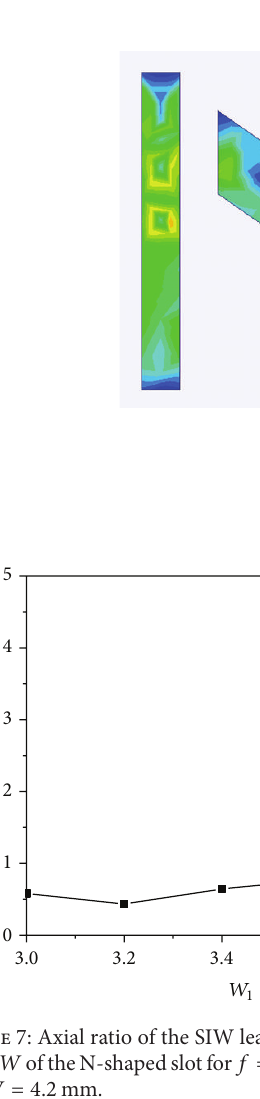
Figure 9: Measured and simulated 𝑆 -parameters of the antenna shown in Figure